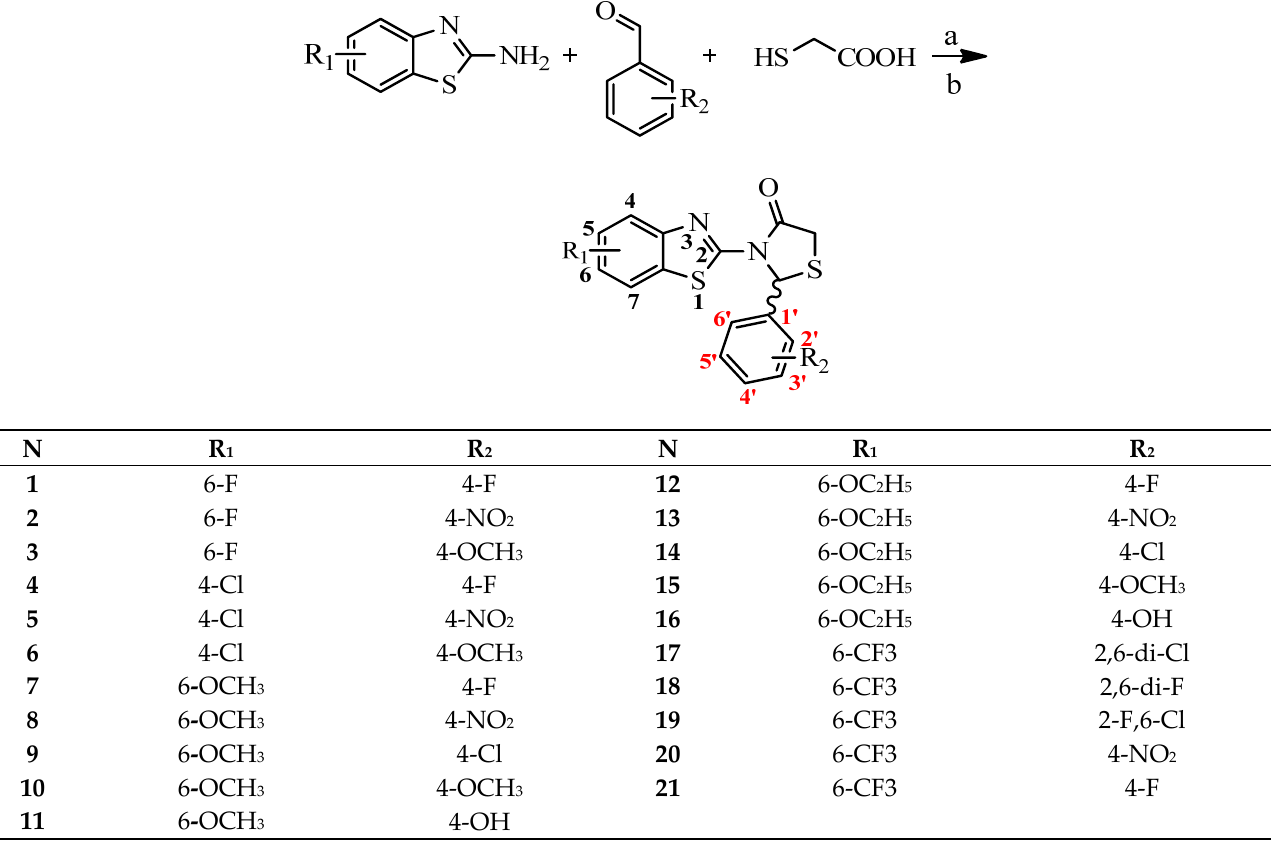
Table 1. Antibacterial activity of compounds (MIC/MBC in